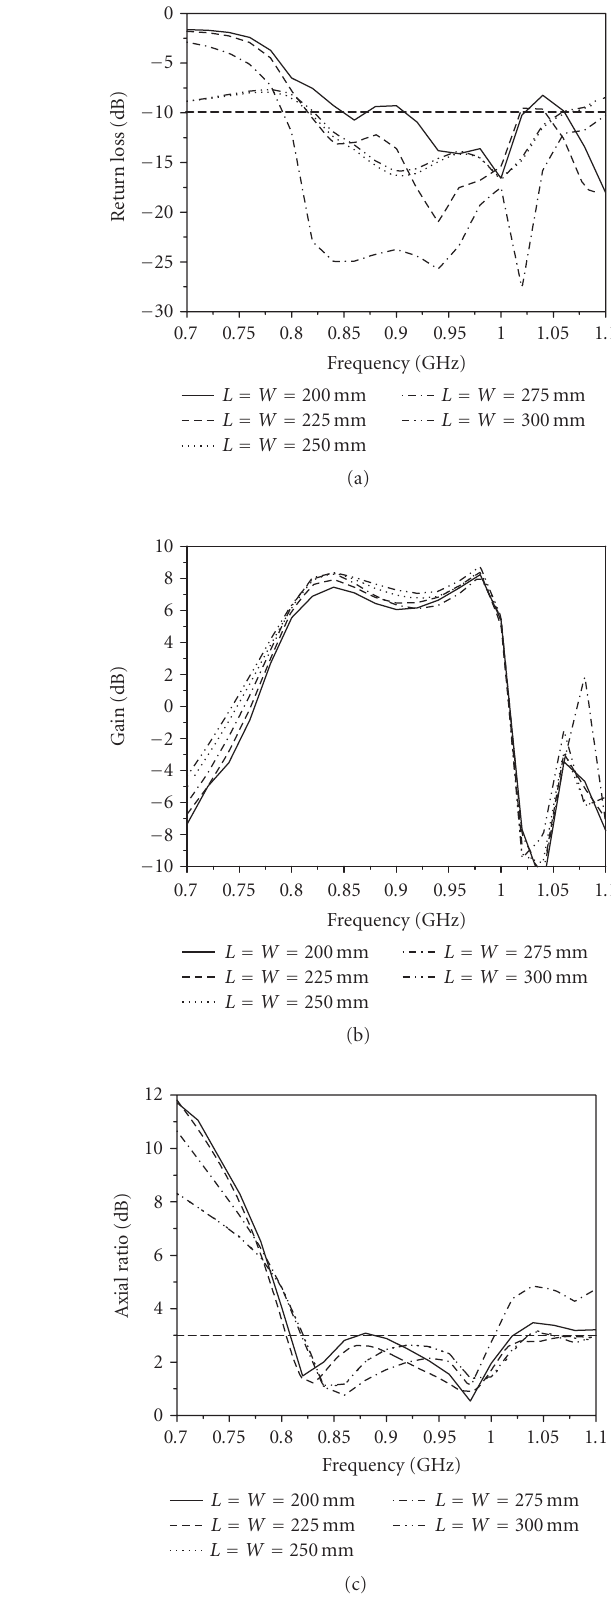
Figure 11: E ff ect of the height of the second stacked patch on the performance of the proposed antenna: (a) return loss; (b) gain; (c) axial ratio.